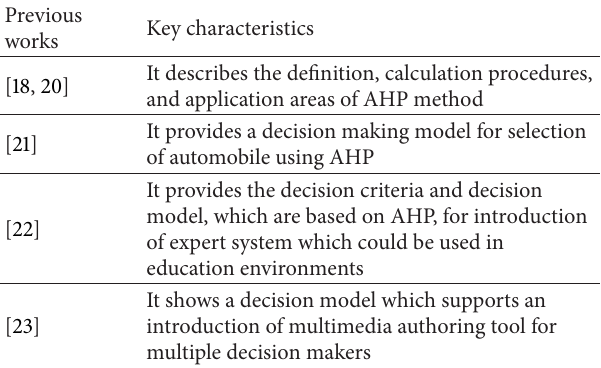
Table 2: Previous works on